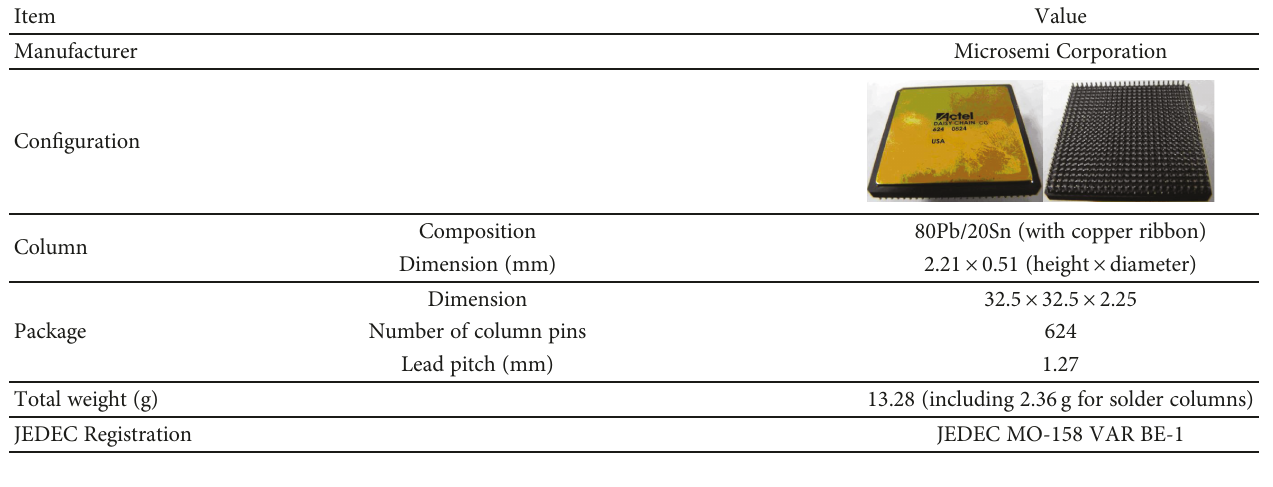
Table 3: Speci fi cations of CCGA624 package [18].